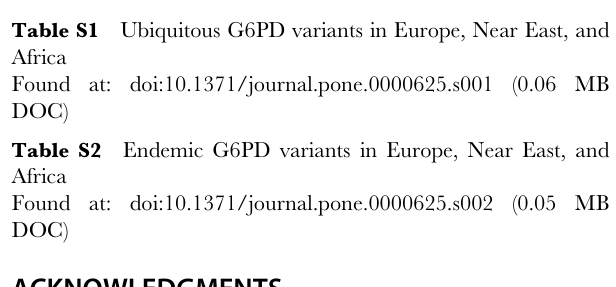
Table S1 Ubiquitous G6PD variants in Europe, Near East, and